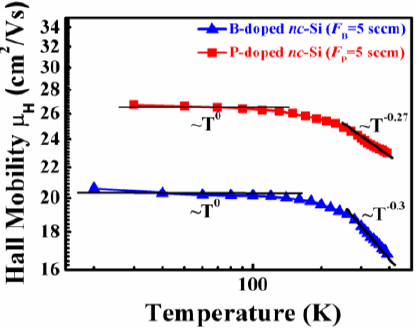
Figure 7. The Hall mobility, μ H , as a function of temperature for the P- and B-doped samples. The lines represent least-squares fits to μ H ( T ) ∝ T n .